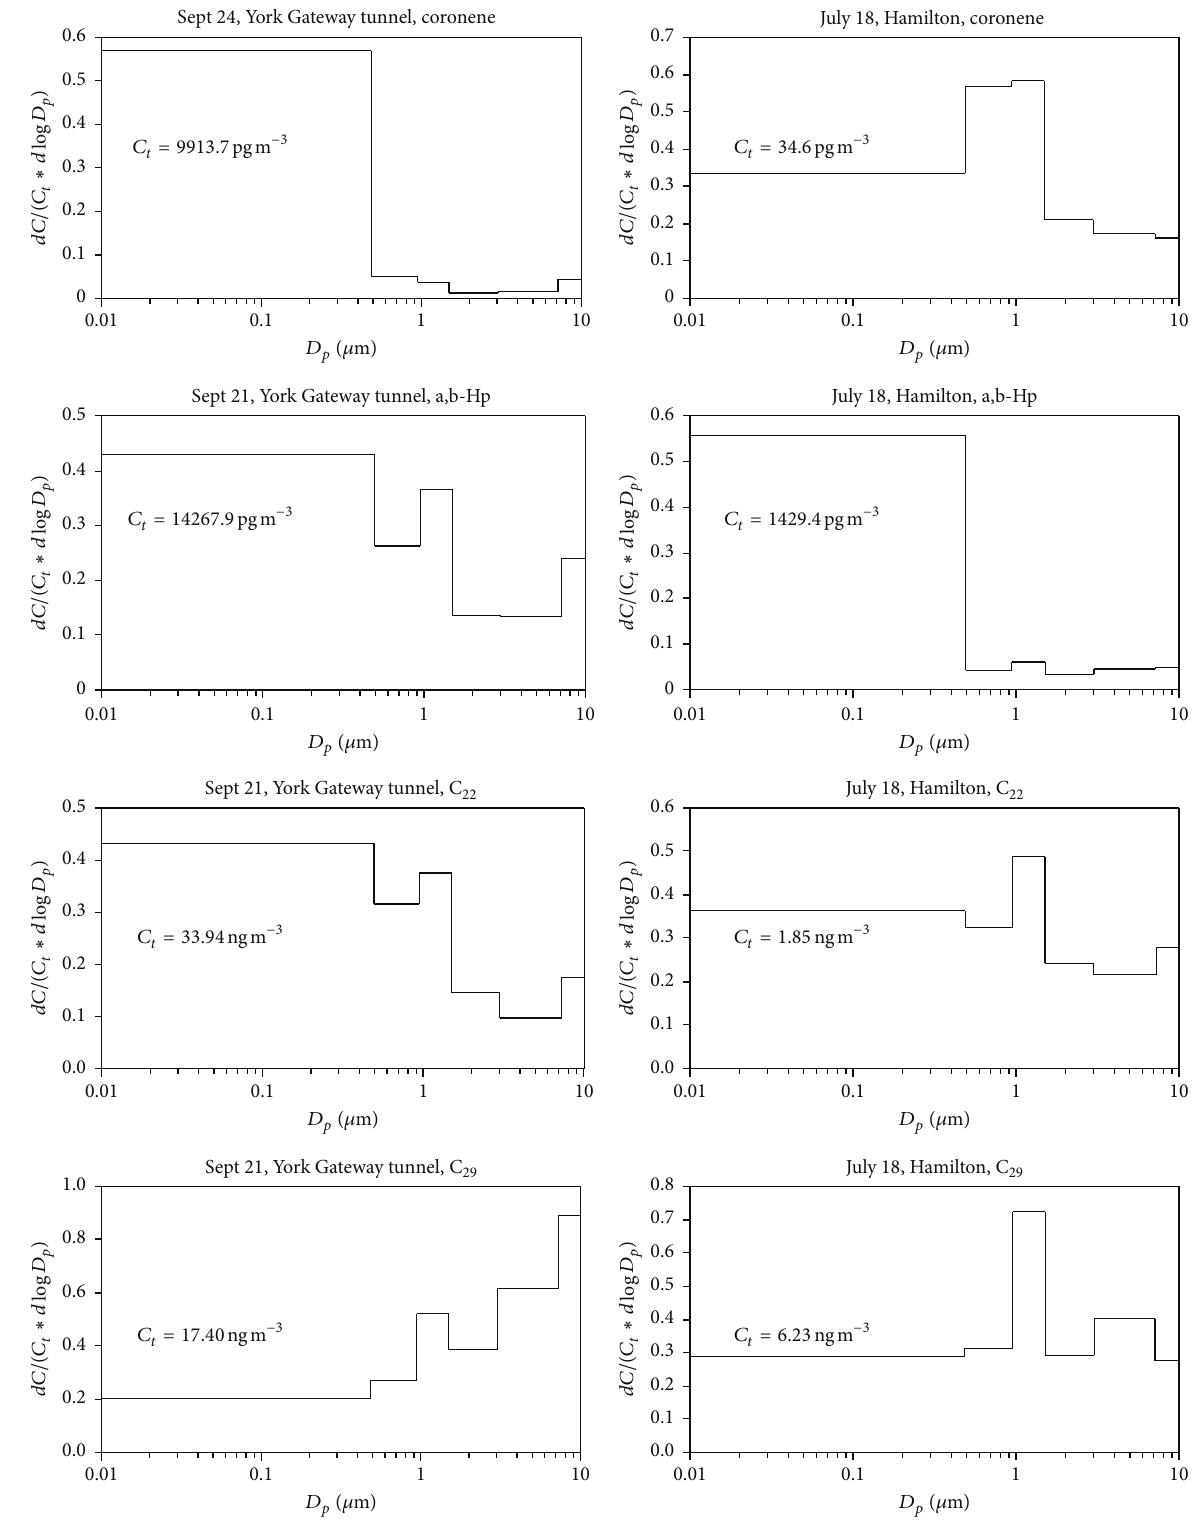
Figure 5: Size distribution of selected molecular marker fractions as a function of size-bin. 𝐶 𝑡 = the sum of concentrations in all